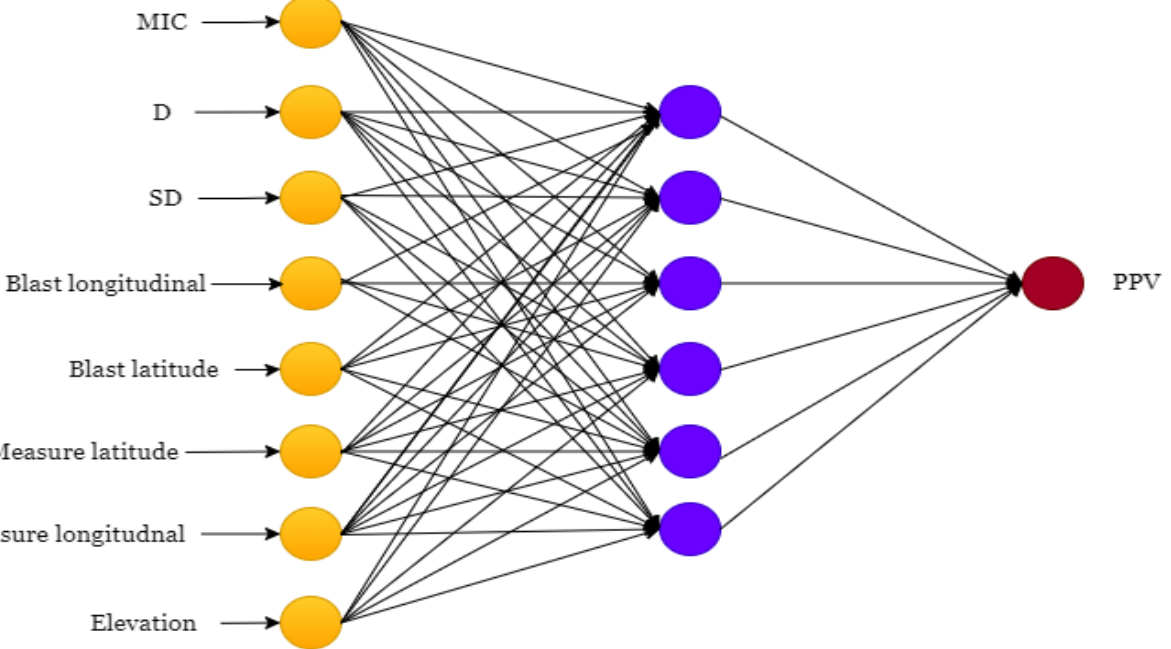
Figure 6. The architecture of a back propagation neural network (BPNN), with its three layers (i.e., input layer, hidden layer, and output layer).